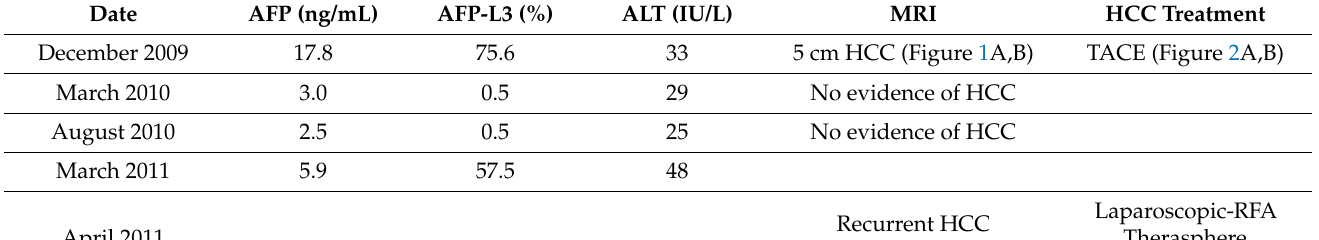
Table 4. Case 4. AFP, L3%, ALT, and MRI findings at various times throughout treatment course.